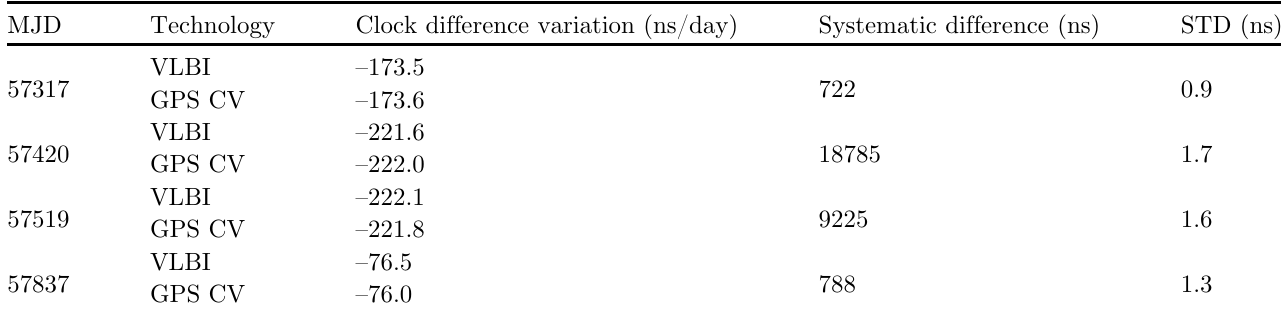
Table 2. Statistical results of time comparisons.